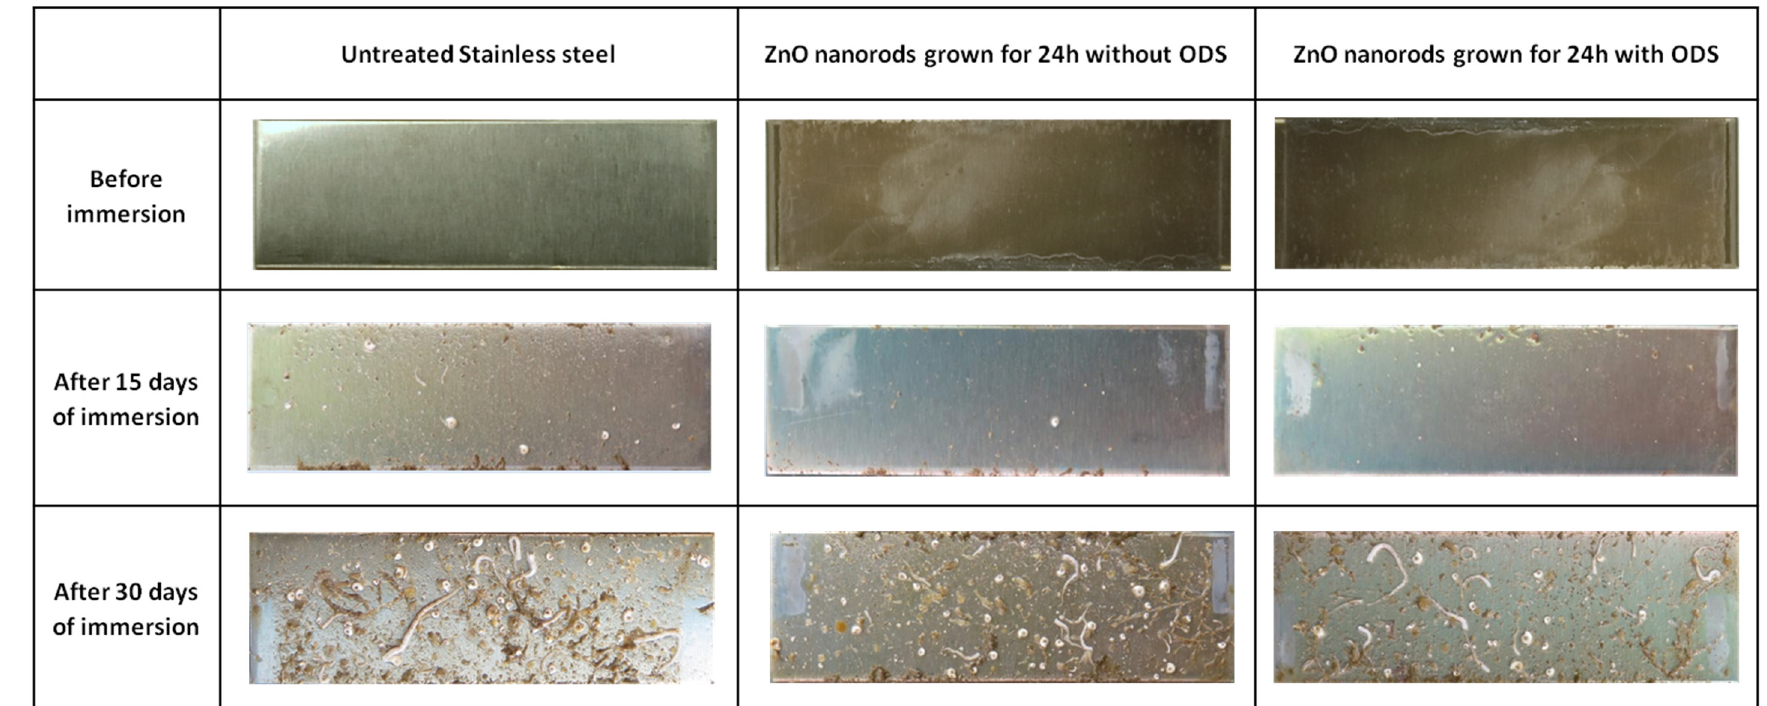
Figure 11. Biofouling on surfaces after 0, 15 and 30 days of immersion.